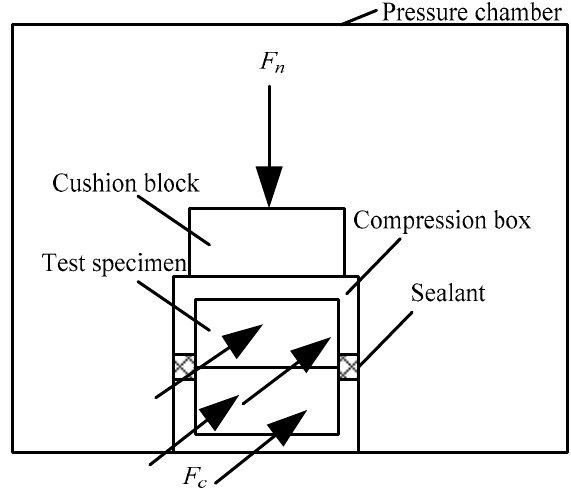
Figure 6. Loading diagram of normal compression test.